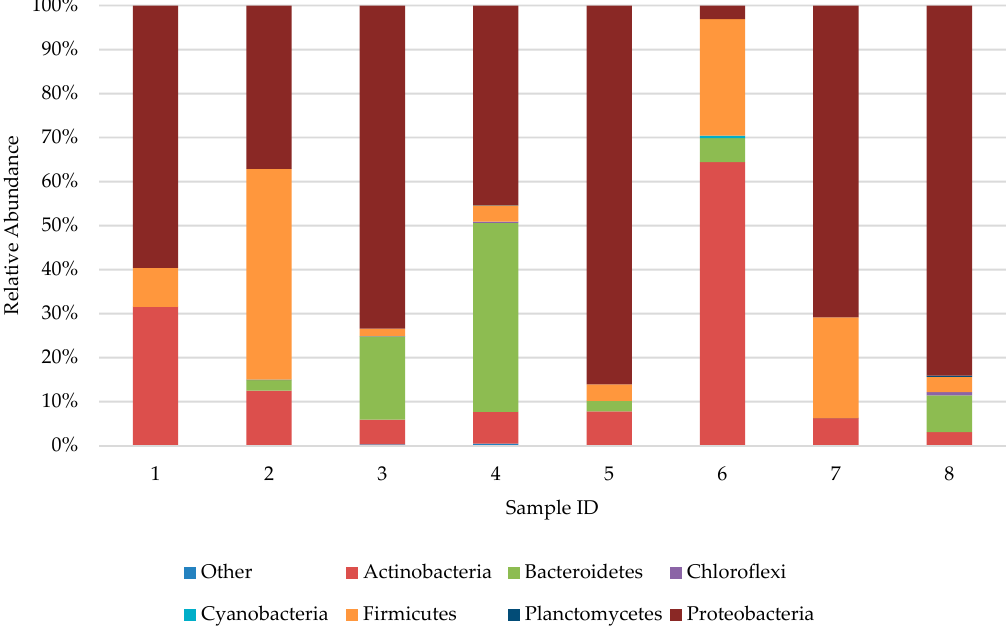
Figure 9. Biodiversity of bacteria in samples acquired from feet skin of examined people. 1—man, 0– 10 years old; 2—woman, 0–10 years old; 3—man, 11–17 years old; 4—woman, 11–17 years old; 5—